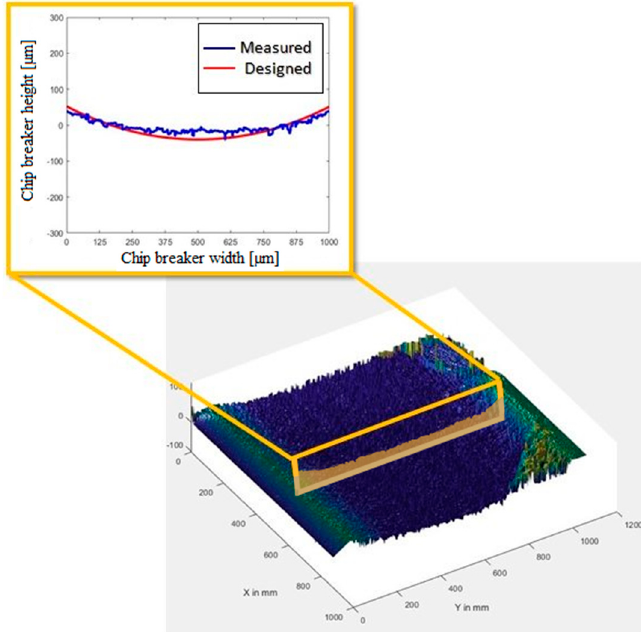
Figure 10. Measurement of the ablated chip breaker in the PCD insert.